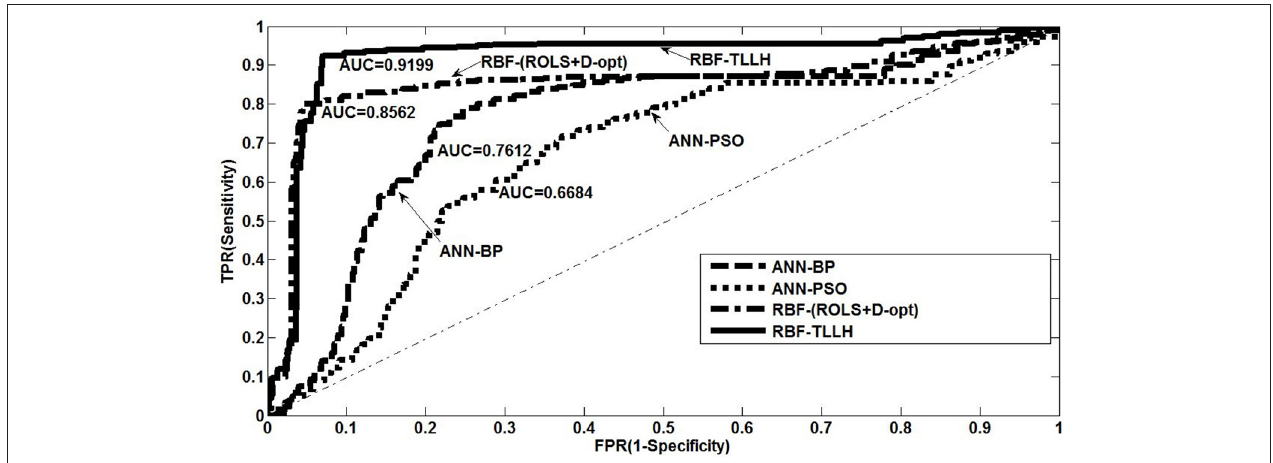
FIGURE 7 | Receiver operating characteristic plot with area under the curve values for different classification models: (1) artificial neural network (ANN) using back-propagation algorithm, (2) ANN using particle swarm optimization, (3) radial basis function (RBF) network using ROLS + D-opt algorithm, and (4) RBF network using two-level learning hierarchy